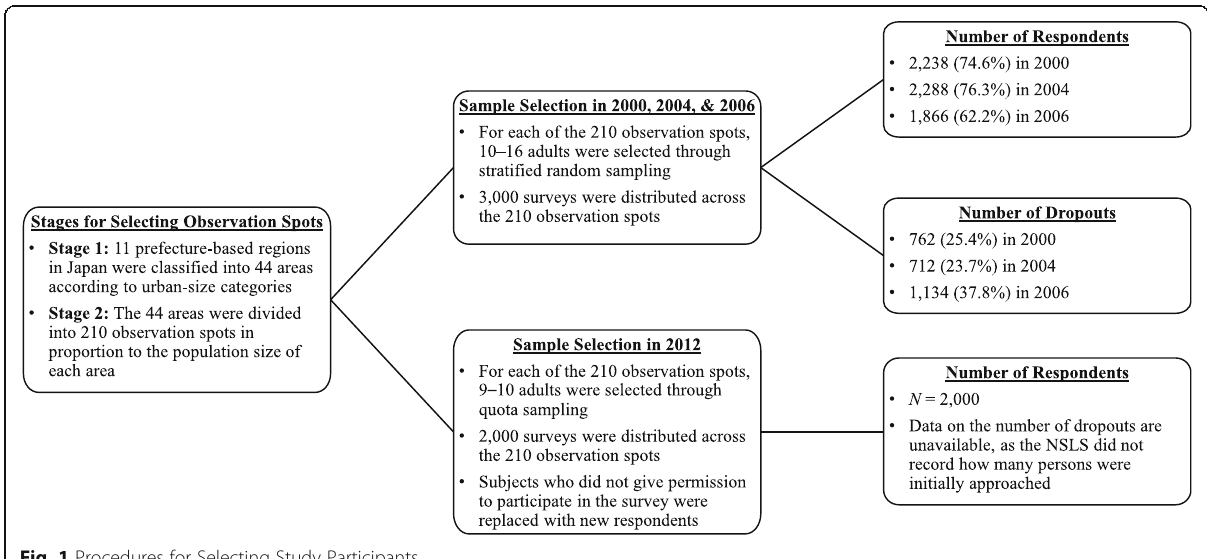
Fig. 1 Procedures for Selecting Study